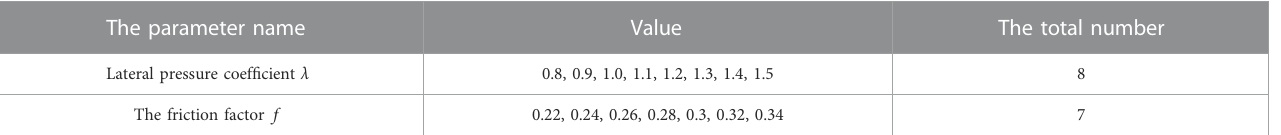
TABLE 1 Parameter assignment of SRPA (Surrounding rock pressure arch).